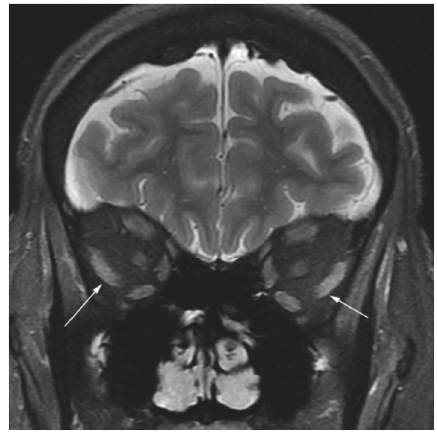
Figure 2: Coronal T2 weighted image through the orbit demon- strates inferior displacement of the lateral rectus muscles bilaterally (arrows) without abnormal